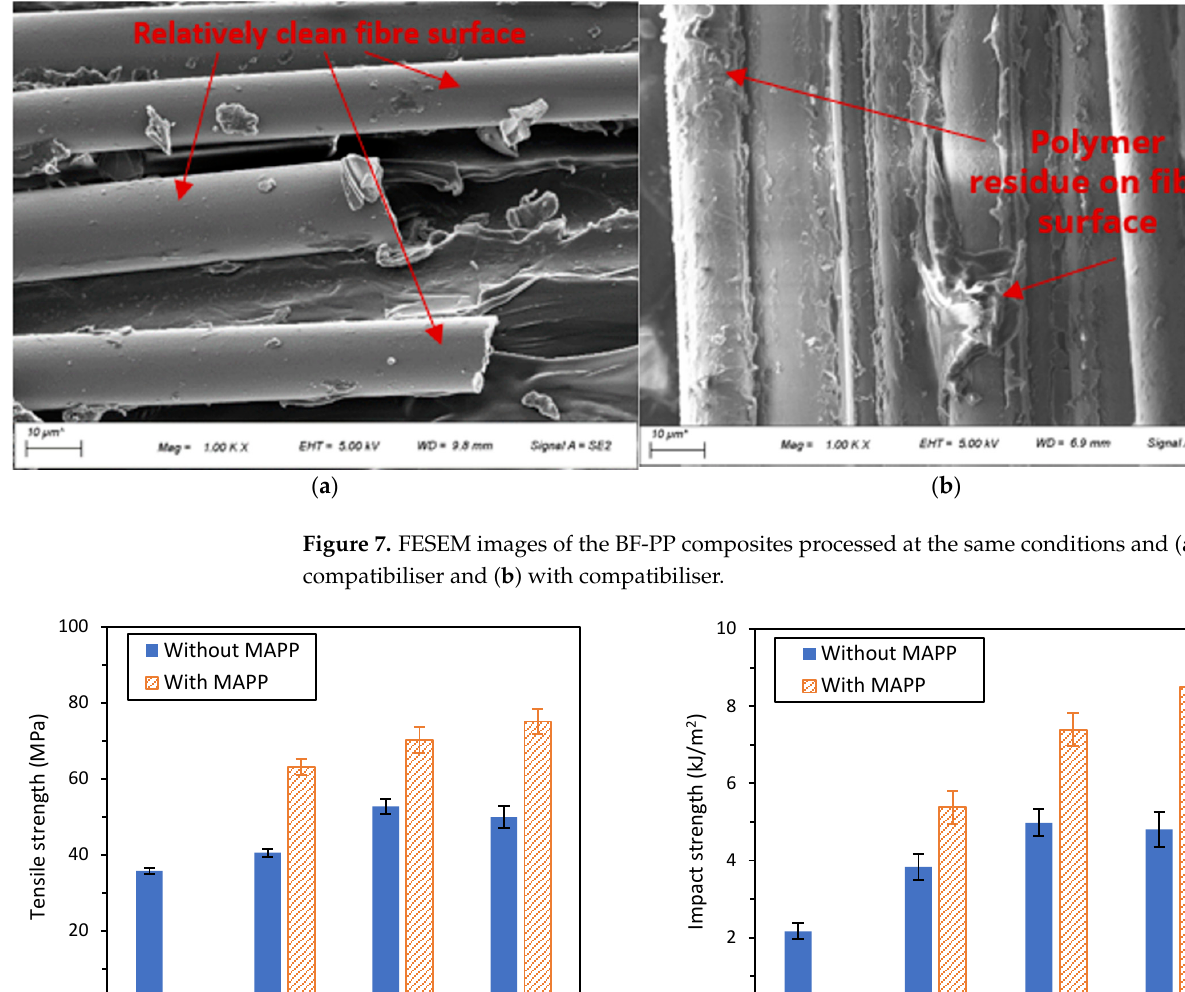
Figure 7. FESEM images of the BF-PP composites processed at the same conditions and ( a ) without compatibiliser and ( b ) with compatibiliser.